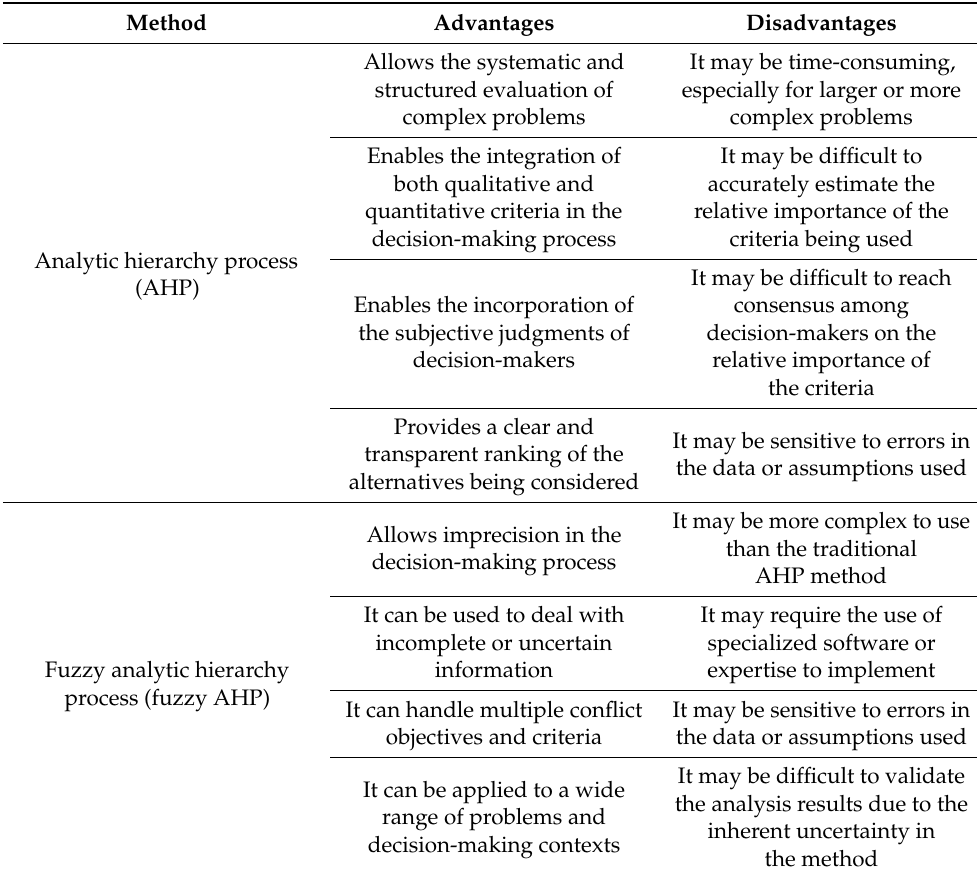
Table 1. Advantages and disadvantages of the methods